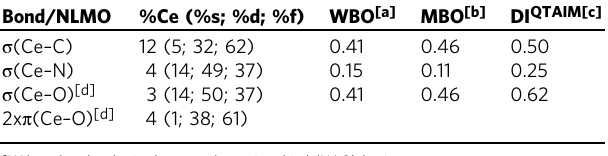
Table 1 NLMO compositions and bond orders for